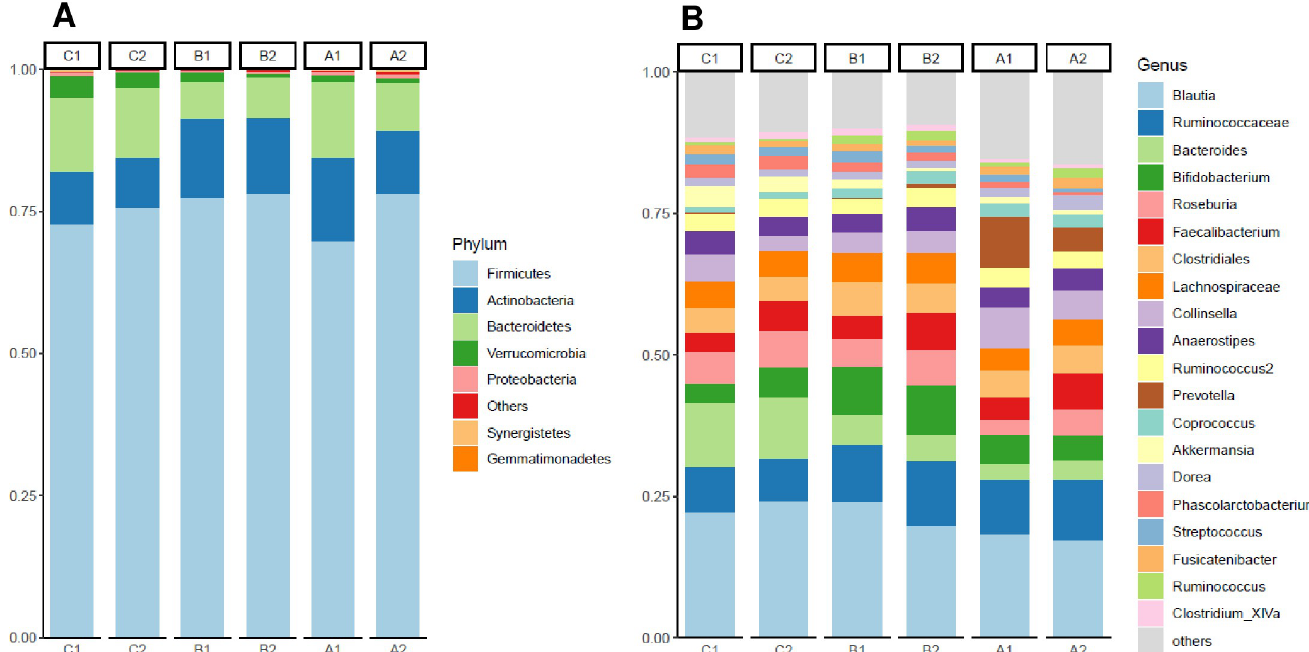
Fig 2. Microbial composition ranked by relative abundance. Observed phyla for treatment groups (A and B) or genus for individual participants (C and D) are shown. A1 = Group A (fermented vegetable) at week 0; A2 = Group A (fermented vegetable) at week 6; B1 = Group B (pickled vegetable) at week 0; B2 = Group B (pickled vegetable) at week 6; C1 = Group C (control) at week 0; C2 = Group C (control) at week 6.